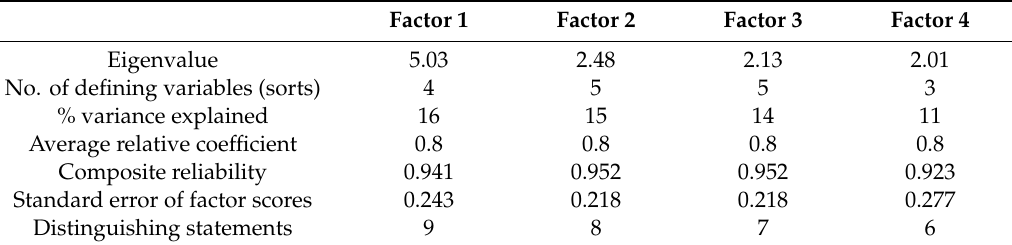
Table 2. Factor characteristics.